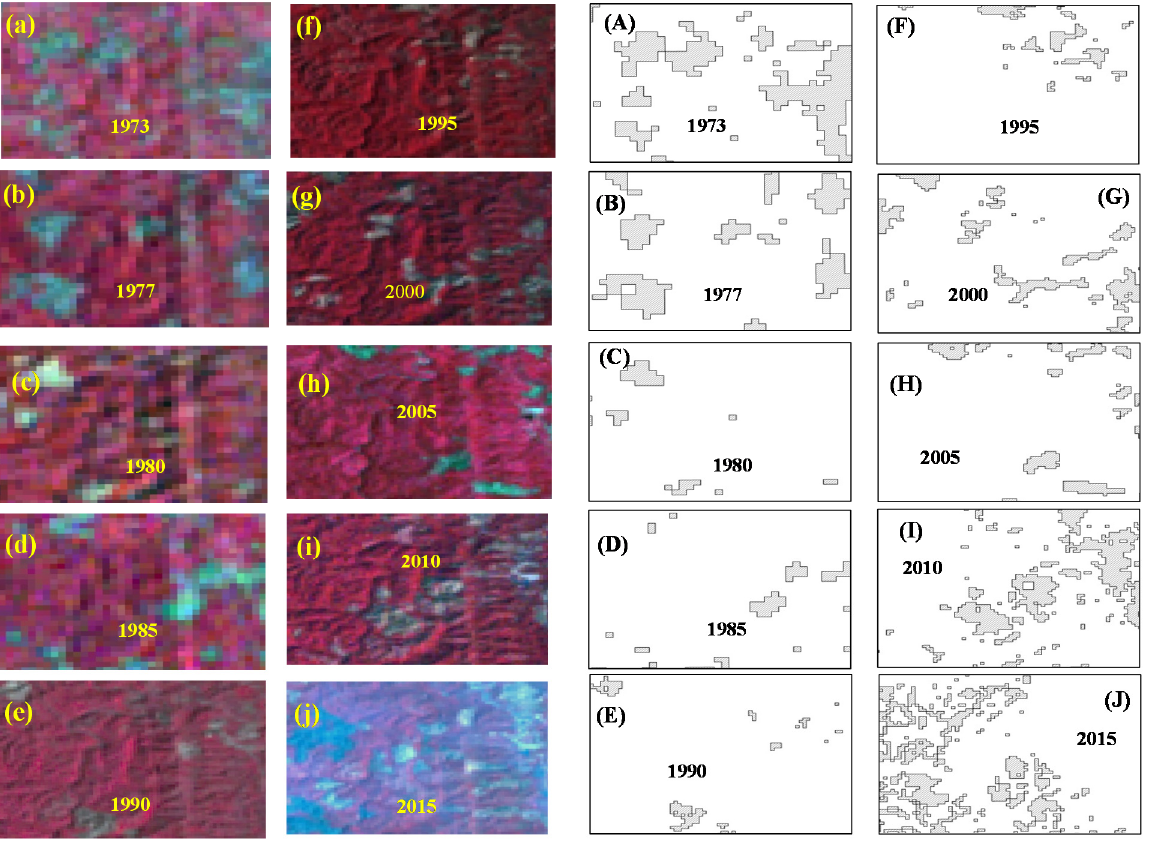
Figure 2. SFCC Landsat images for different time periods (LHS; a – j ) and the corresponding shifting cultivation patches identified from the NDVI change analysis (RHS; A – J